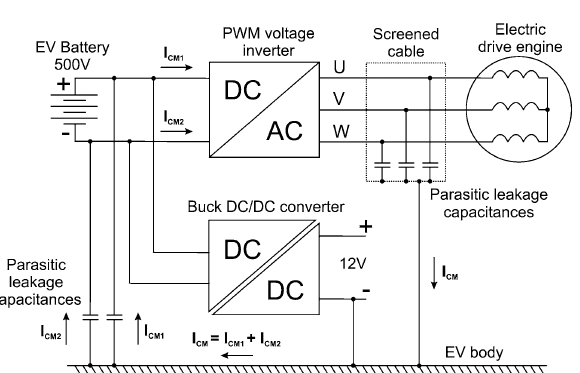
Figure 2. Leakage currents caused by the common-mode voltage of the PWM voltage inverter in the EV drive